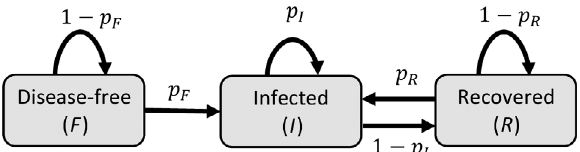
Fig. 3. Stochastic representation of piscirickettsiosis dynam- ics at salmon farm sites. The model includes 3 disease states (boxes) and 6 possible weekly state transitions (arrows). p F , p I , and p R represent the probability of being infected ( I) at week w having been in a disease-free ( F) , I , or recovered ( R) state at week w −